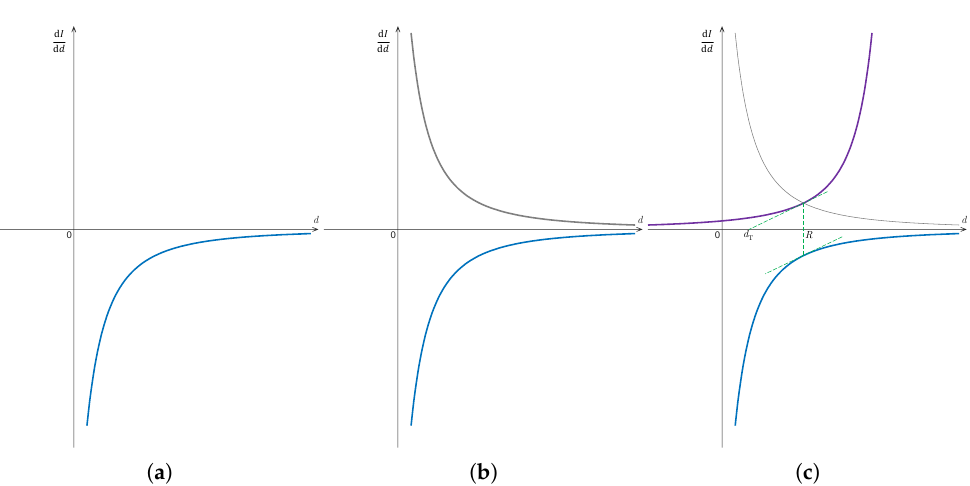
Figure A1. Plots of the first-order derivative of a convex model of coverage and its mirrors: ( a ) original first-order derivative of the convex model (blue), ( b ) mirrored about d axis (gray), and ( c ) further mirrored about d = R